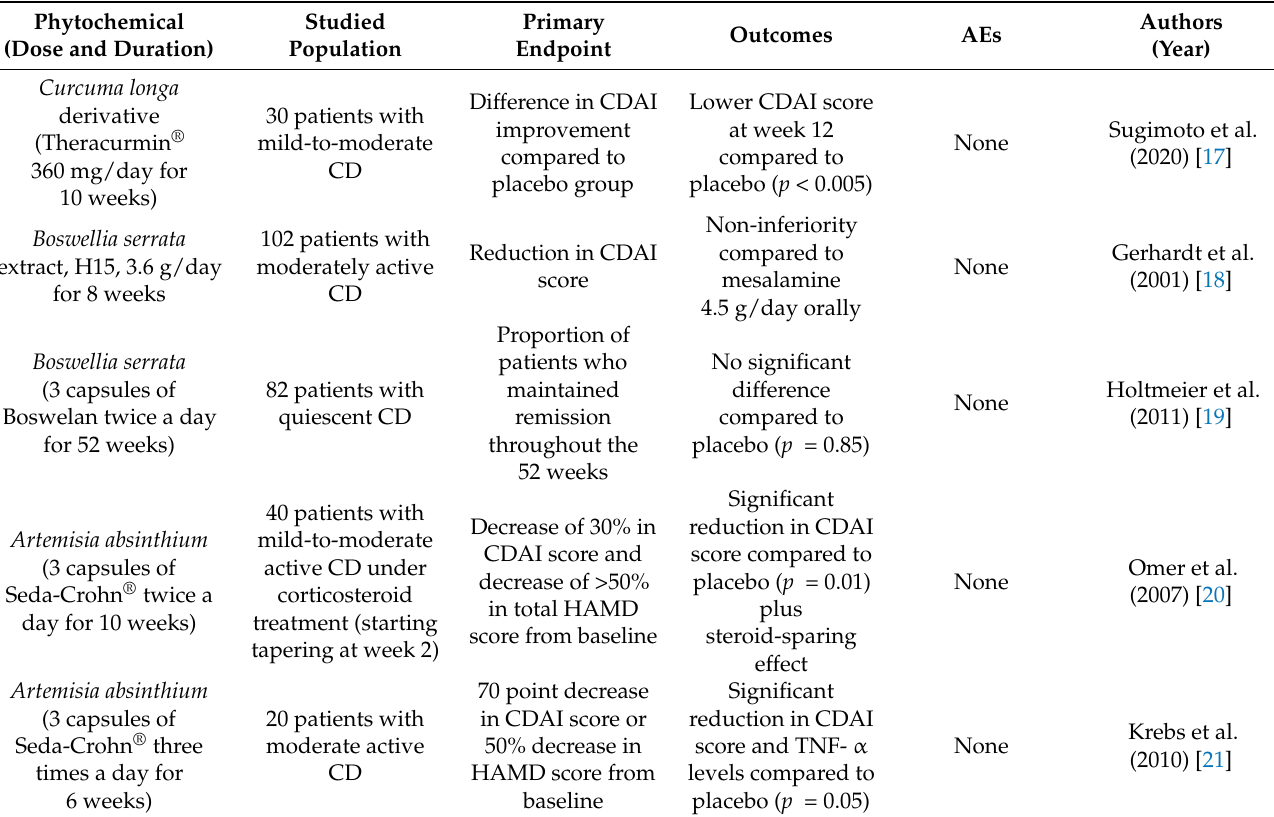
Table 1. Phytochemicals tested in randomized controlled trails over placebo or standard. Treatment- observed outcomes and reported adverse events. AEs: Adverse events; HAMD score: Hamilton Depression Rating Scale; CDAI: Crohn’s Disease Activity